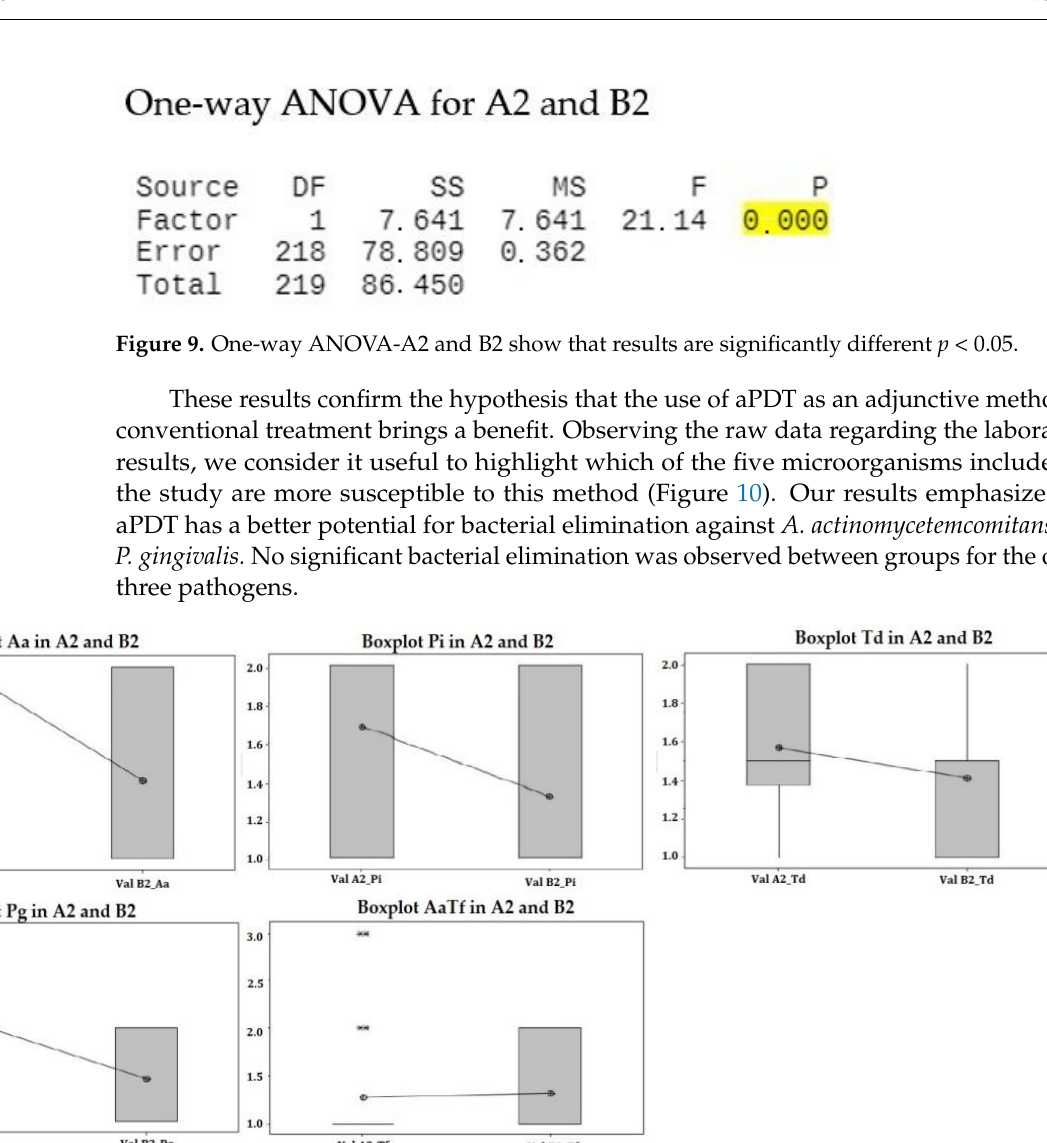
tween these is called the range.